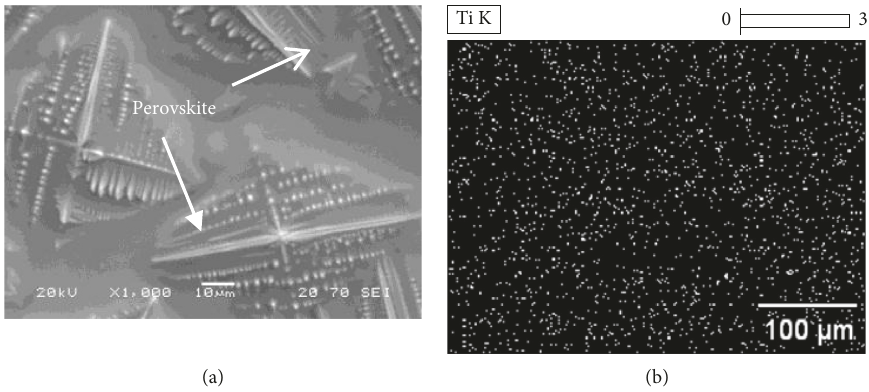
Figure 7: Area scanning mapping of Ti and EDS in 1# sample with 1% B